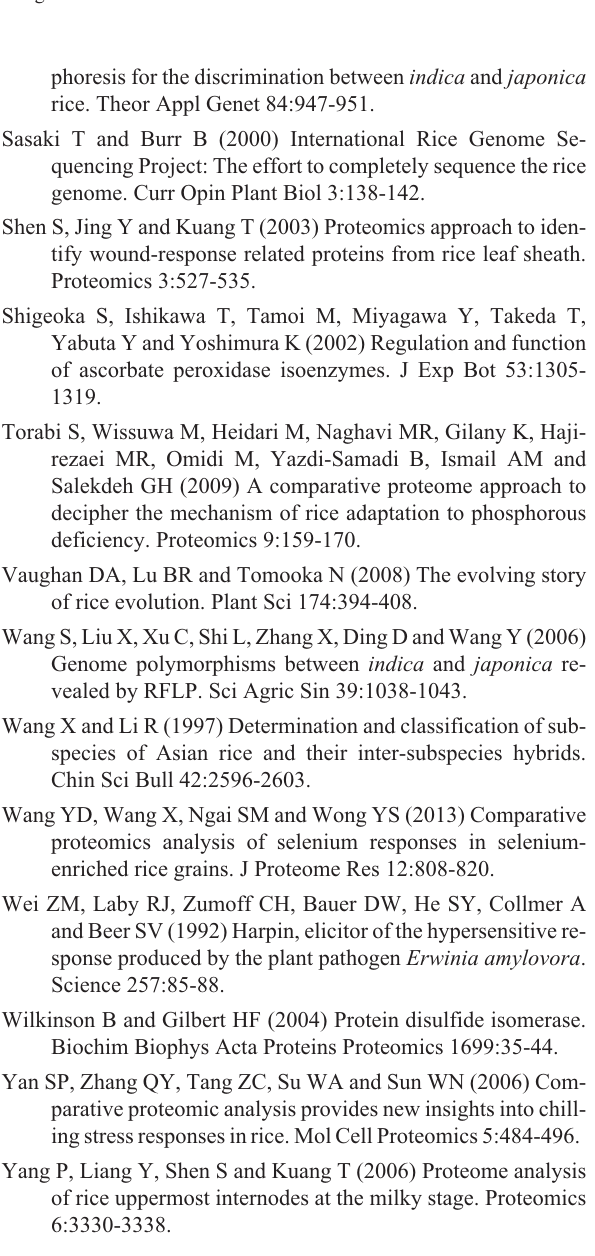
Figure S1 - Triplicate gel images for 93-11. Figure S2 - Triplicate gel images for Nipponbare. Figure S3 - Complete gel images of the indica varieties. Figure S4 - Complete gel images of the japonica